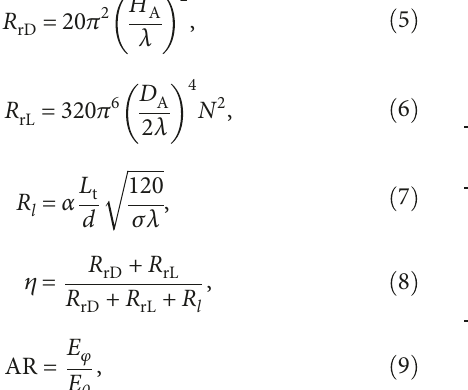
Figure 2: Comparing results calculated by equations and the simulation of NMHA self-resonant structure in free space.